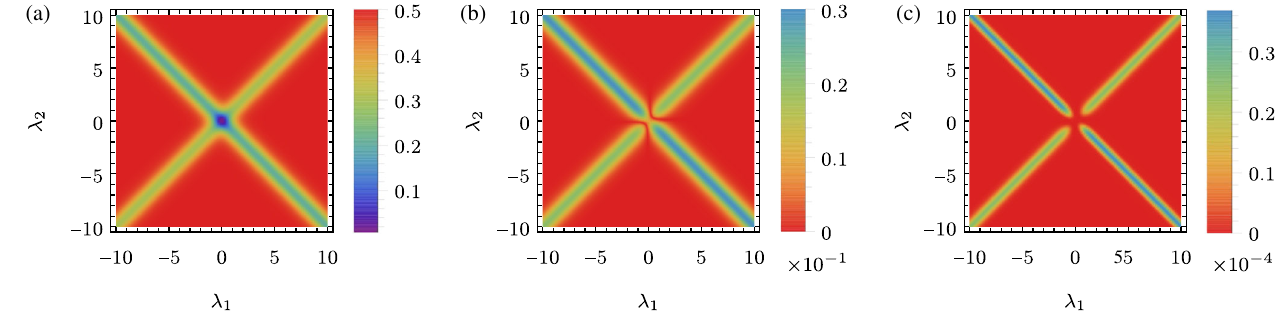
FIG. 4. Density plots of (a) the mutual information of the hiddens with the environment scaled to the mutual information of the visibles with the environment I Λ ð H ∶ E Þ =I ð V ∶ E Þ , (b) the ratio of the NNN to the NN coupling constants j K 0 2 ð 2 Þ =K 0 2 ð 1 Þj , and (c) the ratio of the NN four-point to two-point coupling constants j K 0 4 ð 1 ; 1 ; 1 Þ =K 0 2 ð 1 Þj . All three quantities are shown as a function of the parameters of the RG rule Λ ¼ ð λ 1 ; λ 2 Þ . Note the inverted color scale in (b) and (c). For large enough jj Λ jj 2 , a maximum of mutual information corresponds to a minimum of rangeness and m -bodyness, and vice versa. See the main text and Appendix D 3 for